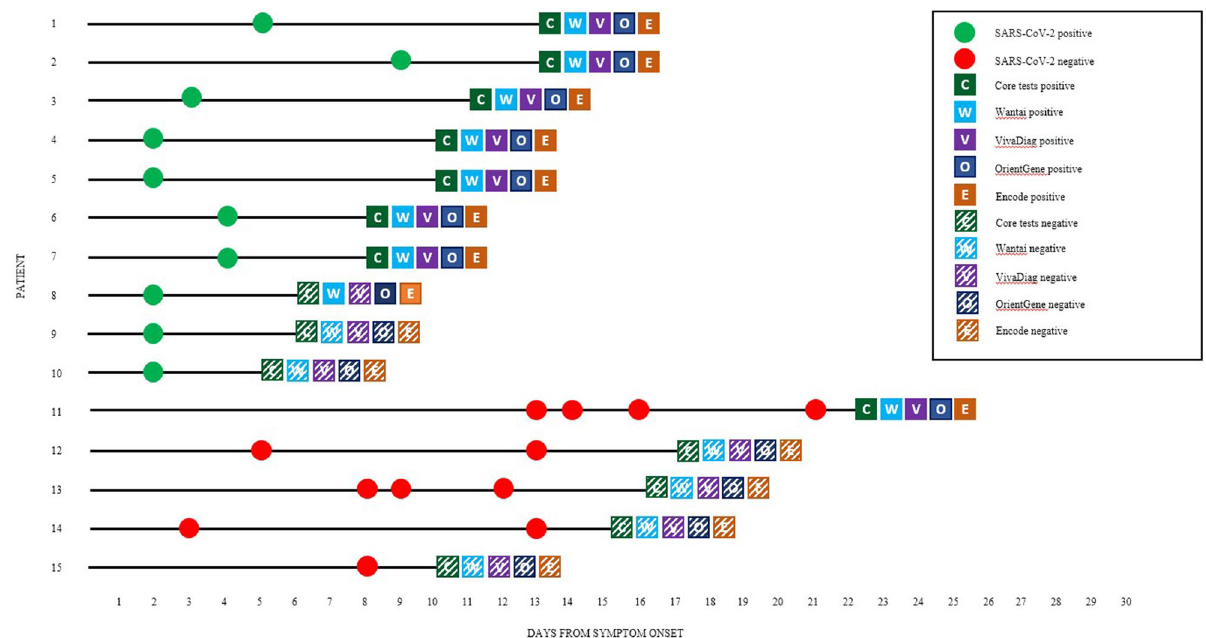
Figure 1. Chronological relationship between onset of symptoms and test results. Results of PCR vs five different point-of-care serological assays among patients meeting the SARS-CoV-2 PHE clinical case definition, March–April 2020,